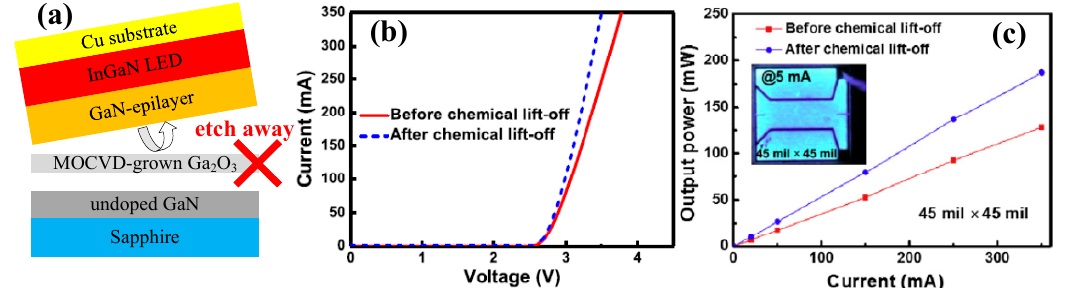
Figure 16. ( a ) Schematic diagram of the chemical lift-off (CLO) process for InGaN/GaN based vertical structure LEDs. ( b ) Current-voltage curves of the LED devices before and after performing the CLO process. ( c ) Light output powers as a function of the injection current for the LED devices before and after performing the CLO process. The inset shows the light emission image at 5 mA of the vertical-type LED (after CLO process) with an emission wavelength of 460 nm. Reprinted with permission from Reference [120]. Copyright 2015 Elsevier.